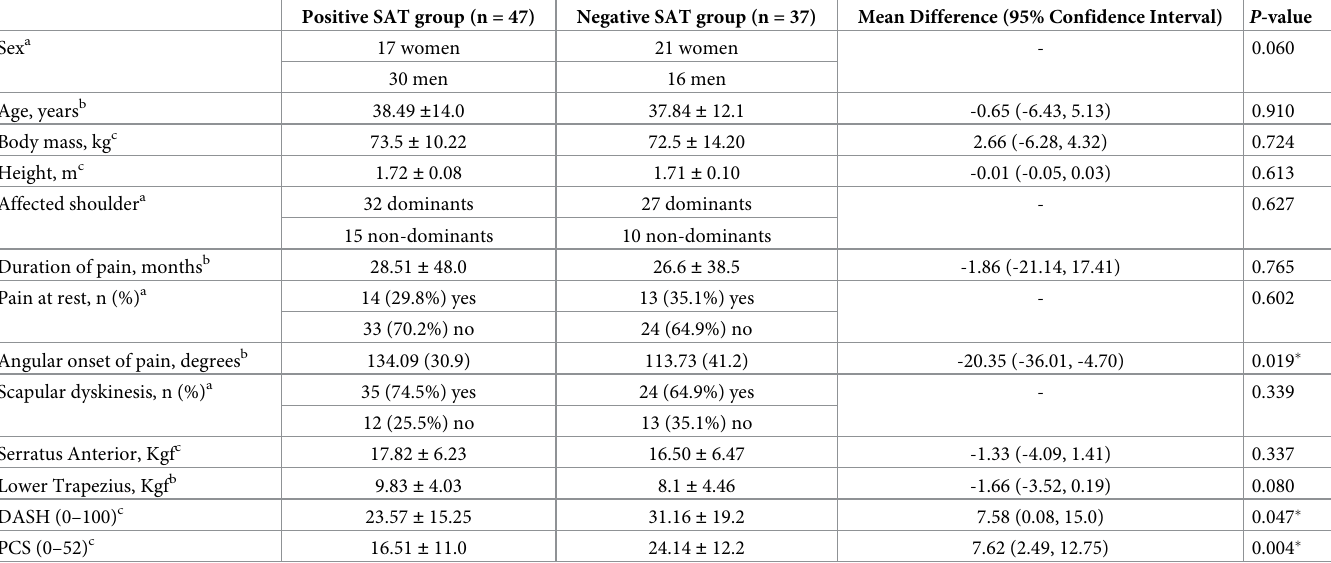
Table 1. Characteristics of the participants and predictive